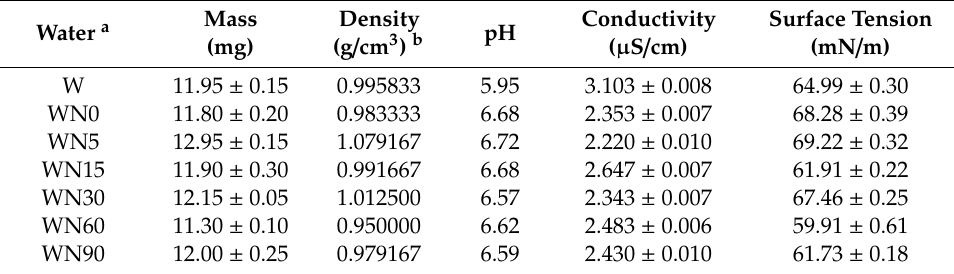
Table 1. Selected physicochemical properties of control waters and water treated with GP under nitrogen.